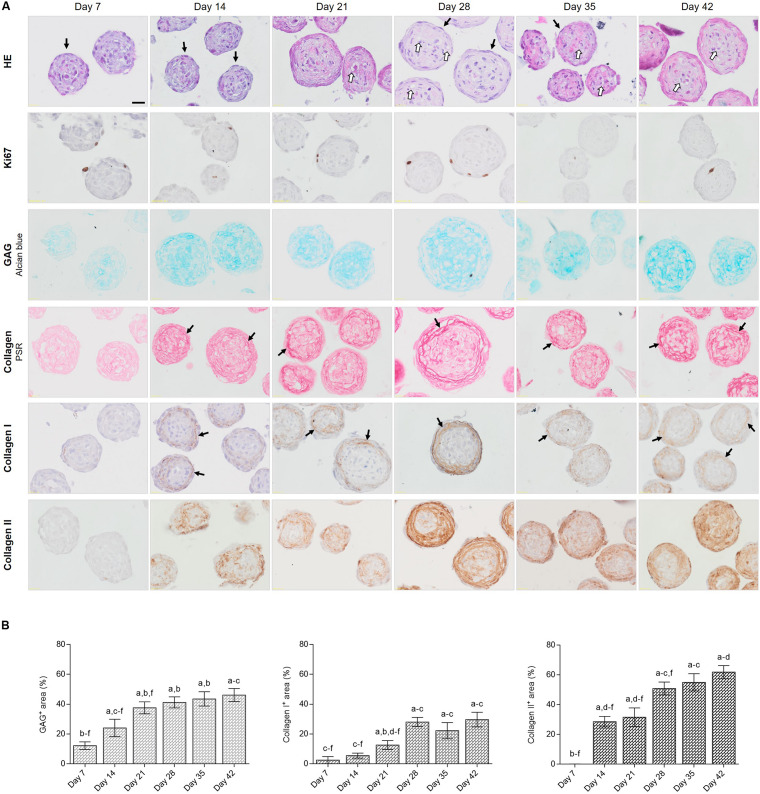
(Immuno)histological evaluation of cartilage microtissues: proliferation and extracellular matrix. (A) HE staining was performed to assess overall morphology, black arrows indicate flattened nuclei of cells at the periphery and white arrows indicate lacunae. IHC staining for Ki67 indicated proliferating cells, Alcian Blue staining showed the presence of glycosaminoglycans (GAG). Collagen was visualized by Picrosirius Red (PSR) staining, black arrows indicate mature fibrillar collagens. IHC stainings for collagen type I and type II were performed, black arrows indicate collagen type I fibers. Scale bar 20 μm. (B) Quantification of GAG, collagen I and collagen II positive stained areas. All data are presented as mean ± 95% CI. Significant differences (p < 0.05) were marked a compared to day 7, b to day 14, c to day 21, d to day 28, e to day 35, and f to day 42 (n = 6, One-way ANOVA followed by a Tukey’s post hoc test).